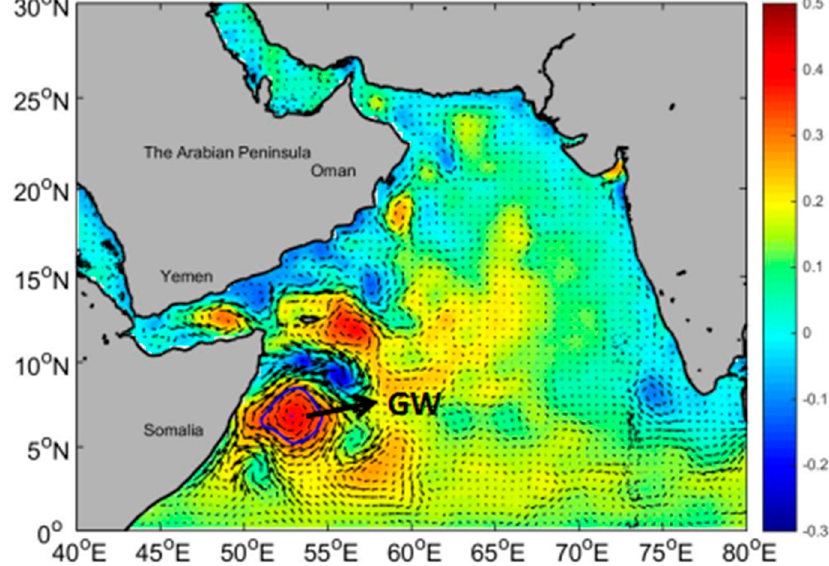
Figure 1. The location of the Great Whirl (GW) (marked by the blue line) on 7 August 2015 (the vectors are the seas surface geostrophic currents, unit: m · s − 1 , background color is sea level anomalies (SLA), unit: m ).